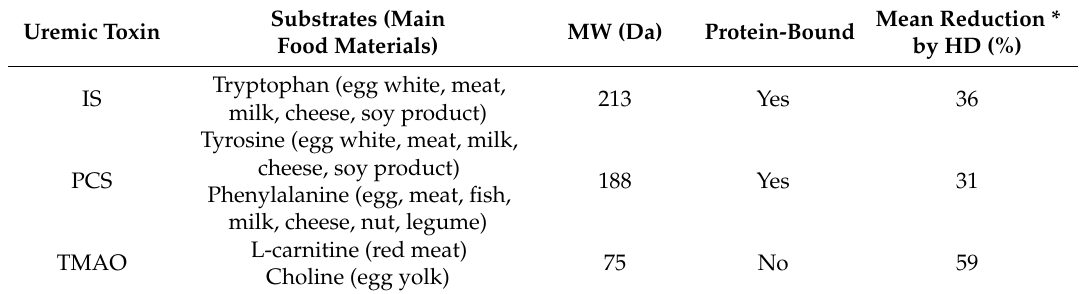
Table 1. Features of gut-derived uremic